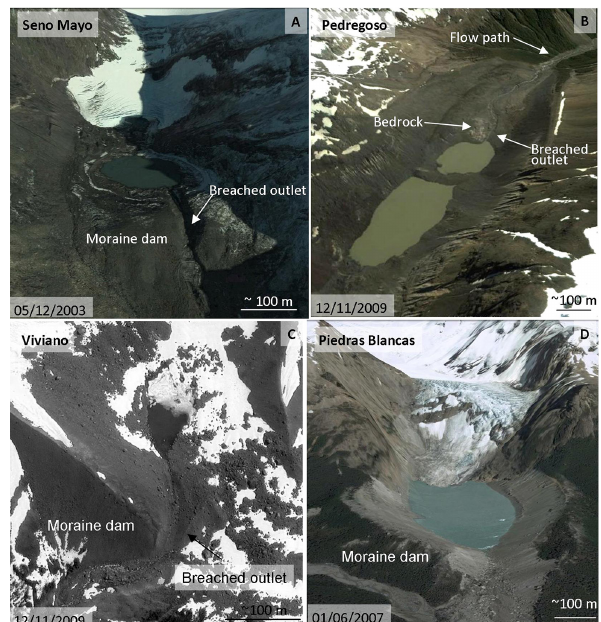
Figure 8. Types of moraine dams failed in Patagonia; (a) lake perched over moraine deposits (b) lake dammed by ground moraines and partially by bedrock (c) lake dammed by a small crest- shaped dam and (d) lake behind large and steep vegetated dam. Im- ages sourced from Google